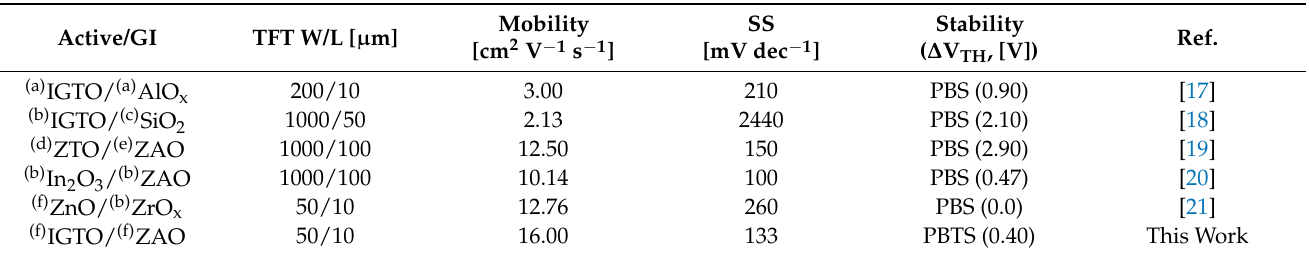
Table 1. Comparison of the electrical properties of oxide TFTs fabricated by spray pyrolysis reported in the